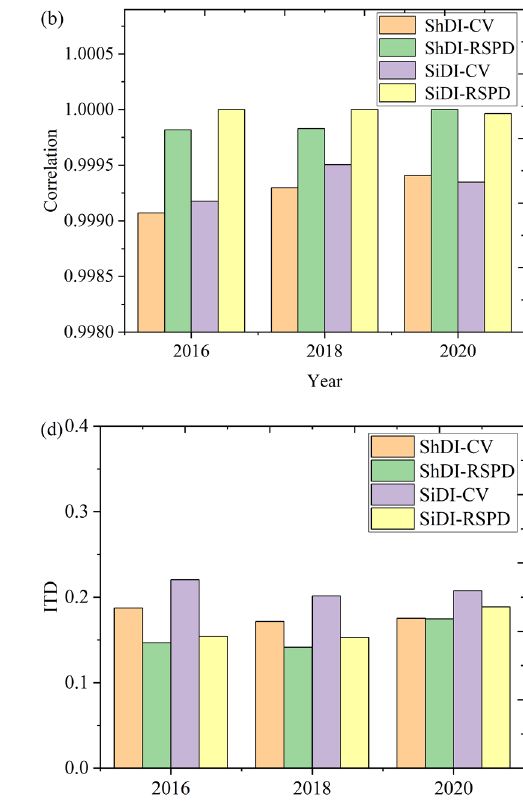
Figure 6. The correlation and image texture difference (ITD) between different methods and ShDI/SiDI (( a ) is the correla ‐ tion result of Case I; ( b ) is the correlation result of Case II; ( c ) is the ITD result of Case I; ( d ) is the ITD result of Case II).